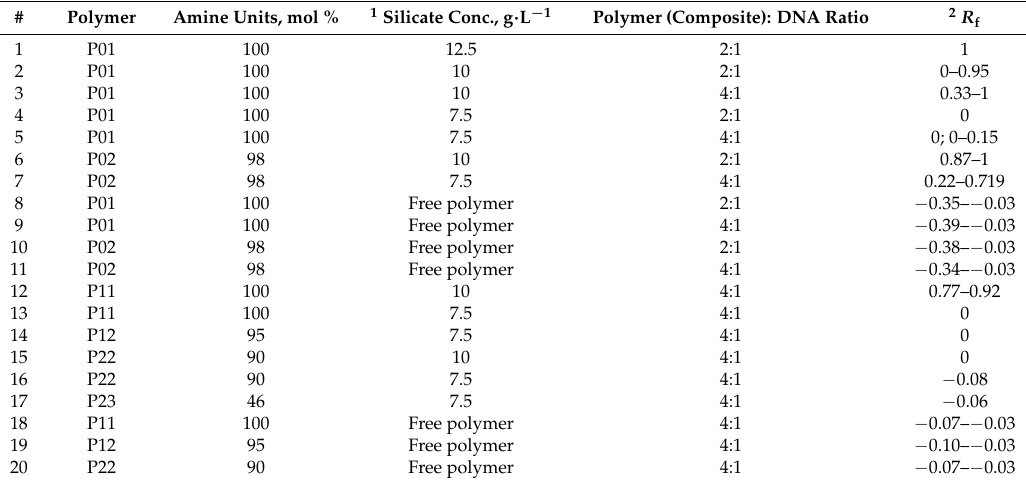
1 DNA oligonucleotide was applied as 10 μ M solution. Polymer concentration was 0.4 g·L − 1 . 2 Negative R f values correspond to substance movement to the negative electrode. Interval of R f values corresponds to spreading electrophoretic blots.